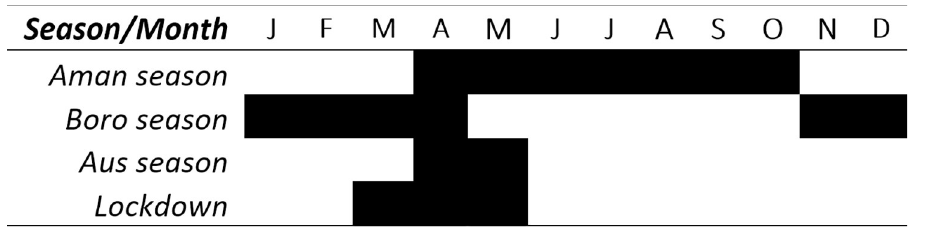
Fig 1. Agricultural seasons and lockdown 2020 in